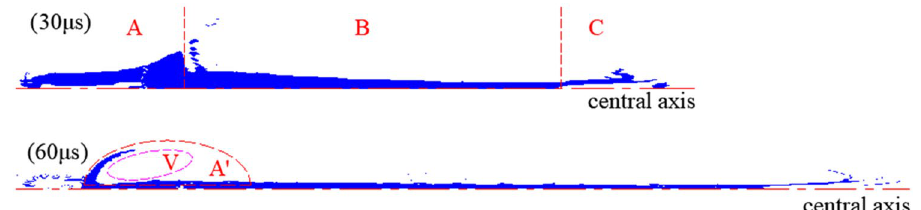
Figure 9. Distribution of radial velocity.